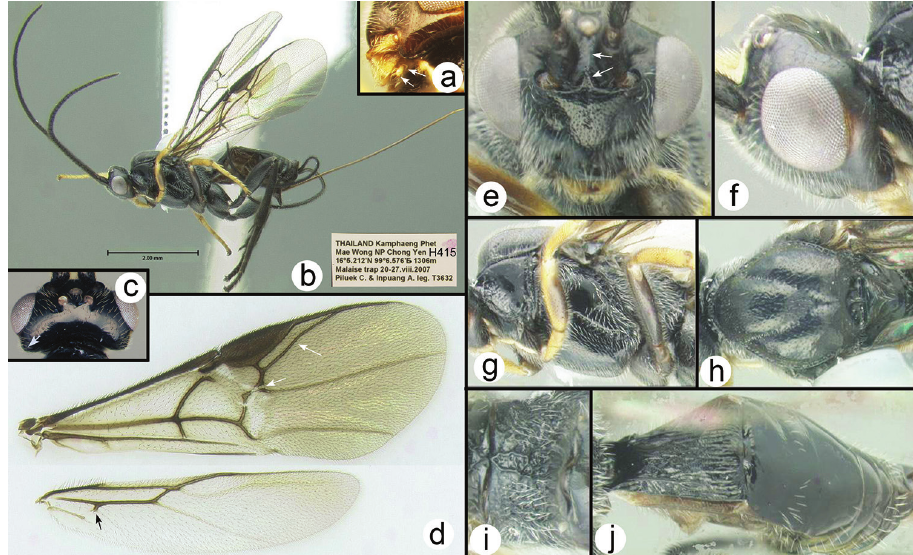
Figure 2. Agathigma templei holotype female: a labial palpus, arrows indicate the two palpomeres b lateral habitus c dorsal head d wings; arrows from top to bottom indicate: RS vein; minute second submarginal cell; angle in cu-a crossvein of hind wing e anterodorsal head, arrows indicate ridge between antennae f lateral head g lateral mesosoma h dorsal mesonotum i dorsal propodeum j dorsal metasoma. Asperagathis Sharkey, gen.